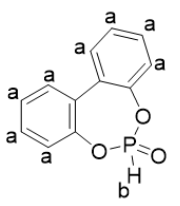
Figure 15. MBDAC-DPP structure.